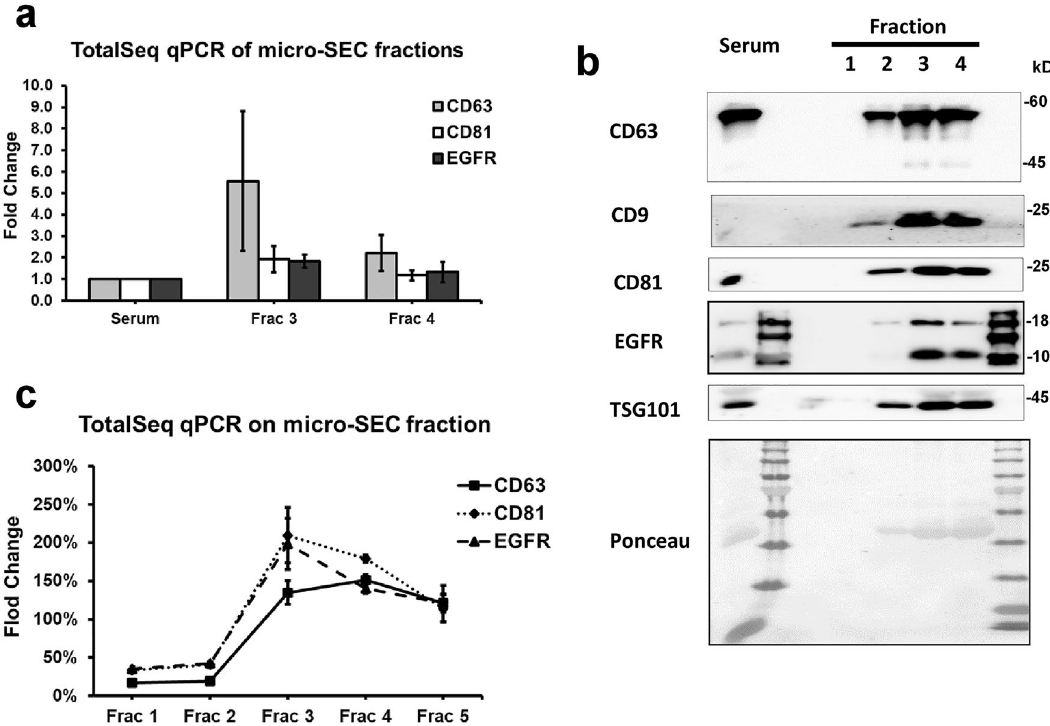
Figure 4. Serum EV protein was profiled using micro-SEC combined with TotalSeq antibody. ( a ) Fraction 3 and 4 collected from micro-SEC on human serum sample were tested with TotalSeq qPCR. Equal protein was blotted on the strip. Data were normalized to serum sample. ( b ) Equal volume of Fraction 1–4 from the micro- SEC were run on SDS-PAGE for immunoblot on EV markers. Full-length blots are presented in Supplementary Figure S8. ( c ) Same fraction sample as in ( b ) were analyzed by TotalSeq qPCR also blotted by equal volume. Data were normalized to serum sample.